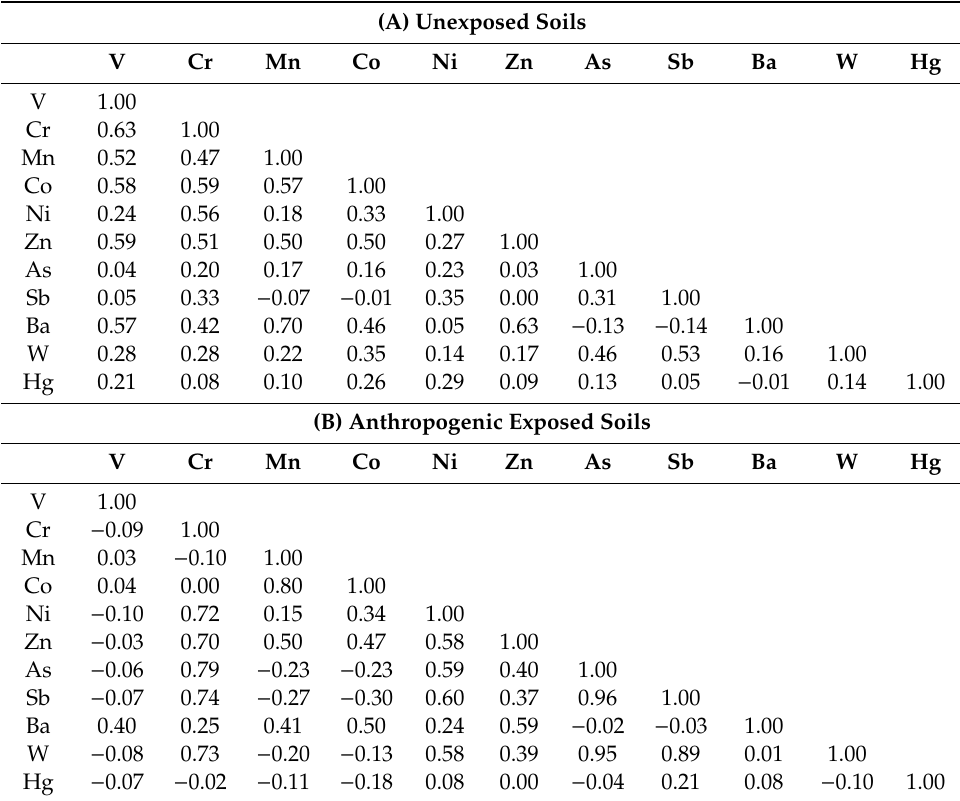
Table 3. Matrix of the Spearman’s correlation coe ffi cient of presumed contaminant elements in soil samples (in bold correlation coe ffi cients at p <